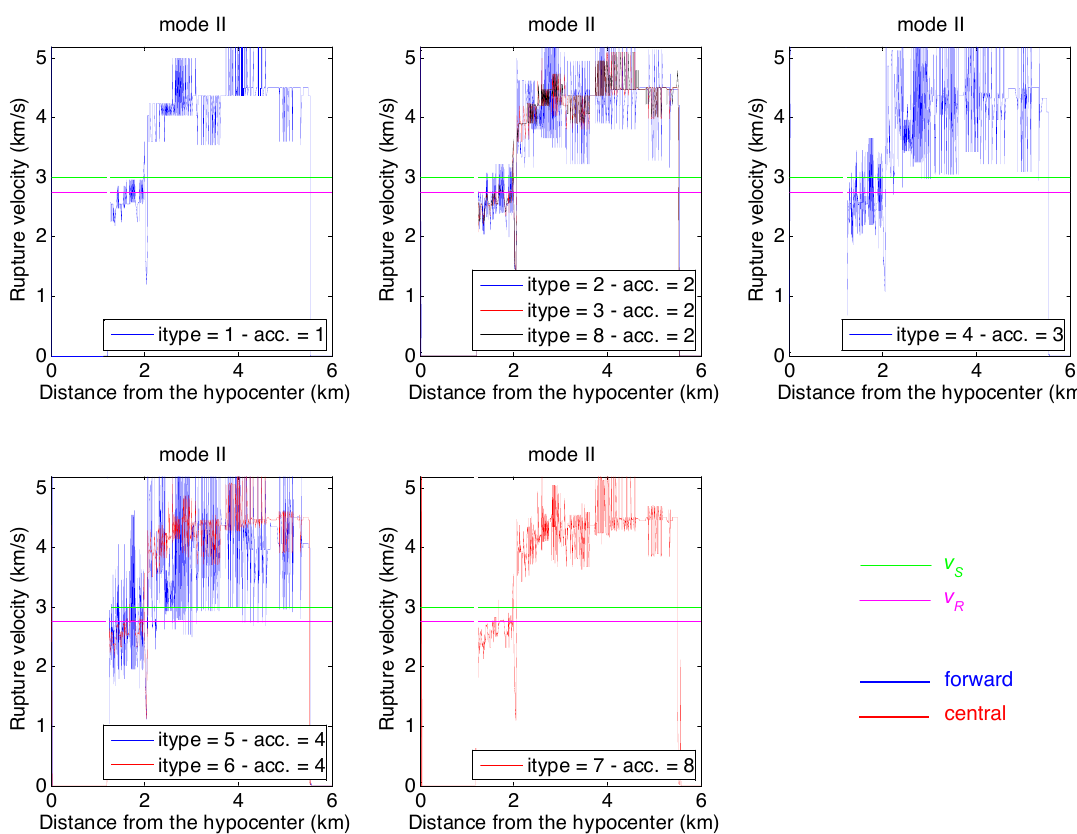
Figure 10. The same as in Figure 2, but now for a heterogeneous configuration, which is described in details in Section 4.